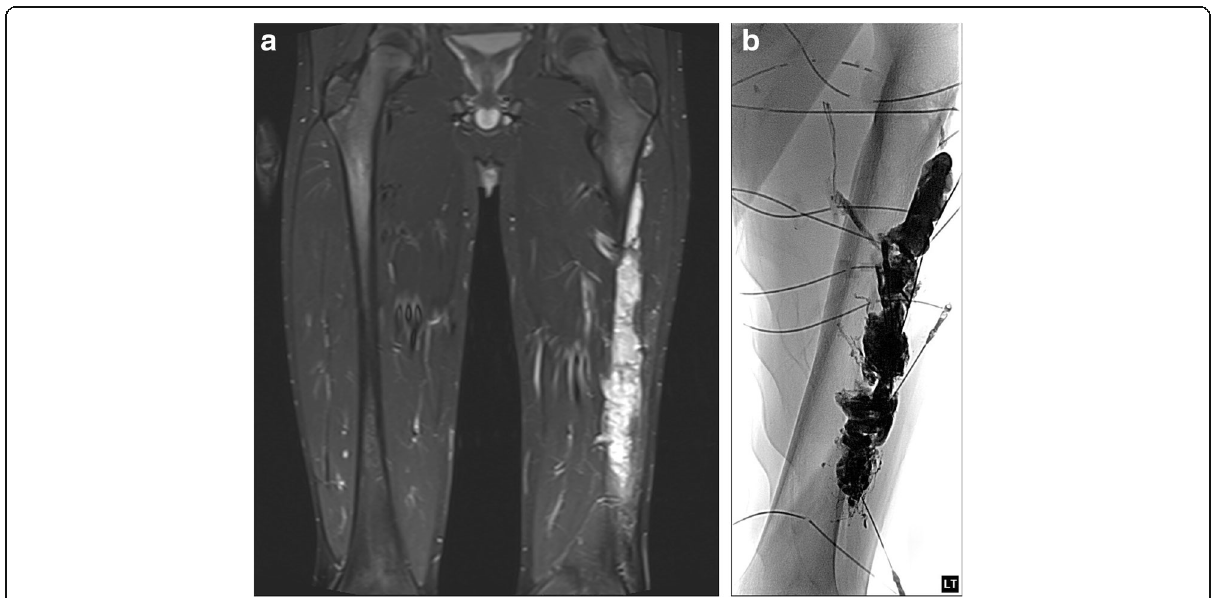
Fig. 2 a Pre-operative coronal T2 weighted MRI in a 14-year-old male with a large (2.7 × 3.2 × 21.2 cm) intramuscular left vastus lateralis VM. He had undergone 3 prior stand-alone excisions but had persistent symptoms and large residual VM. b Post-embolization frontal spot image showing n -BCA glue embolization of the lesion, using multiple points of percutaneous